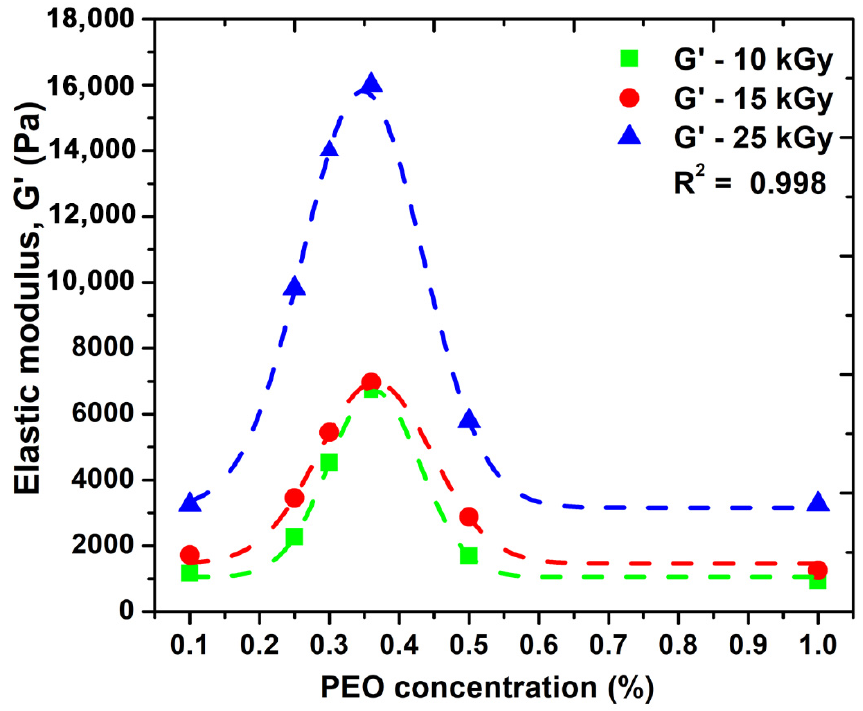
Figure 3. The effect of PEO concentration on the elastic modulus, G ′ .